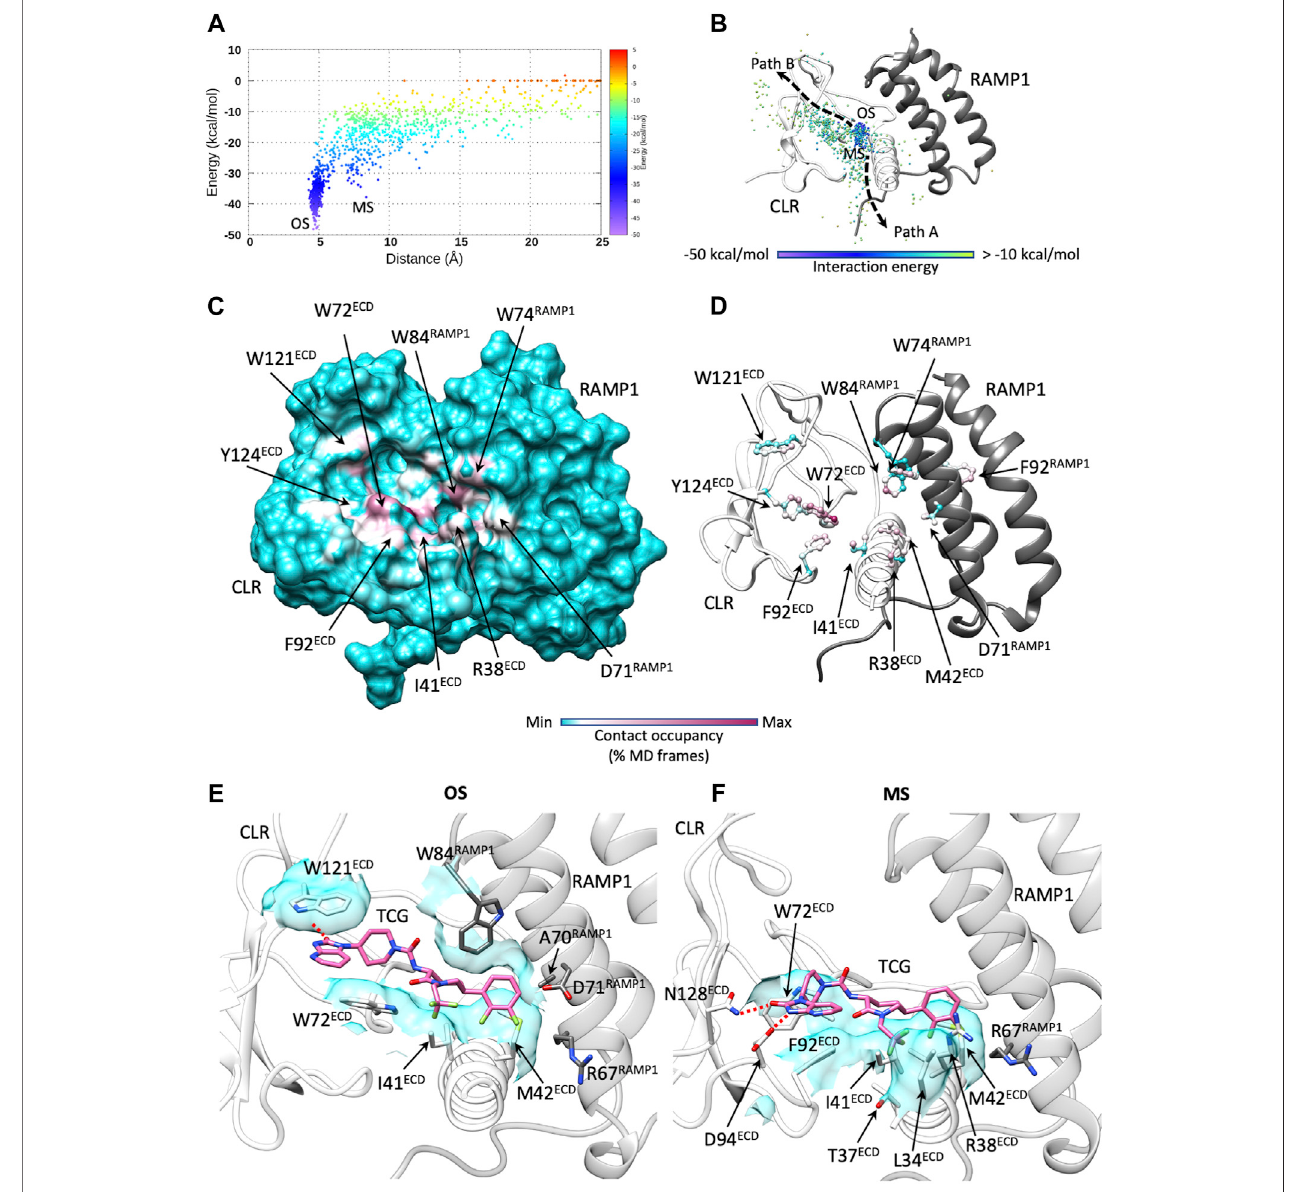
FIGURE 5 | Telcagepant dynamic unbinding. (A) Telcagepant unbinding energy landscape (the metastable macrostates, MS, are indicated, alongside the stable bound states OS); (B) unbinding paths of the centroid of telcagepant, colored according to the interaction energy with CGRPR (the metastable macrostates, MS, are indicated, alongside the stable bound states, OS); (C) Telcagepant-CGRPR contacts plotted on CGRPR surface and colored according to the occupancy (% MD frames) of the interactions; (D) Telcagepant-CGRPR contacts plotted on CGRPR atoms and colored according to the occupancy (% MD frames) of the interactions; (E) representative con fi guration from the stable bound state, OS; (F) representative con fi guration from the metastable macrostate, MS. Electrostatic interactions are depicted as red dashed lines, while hydrophobic contacts are shown as cyan transparent